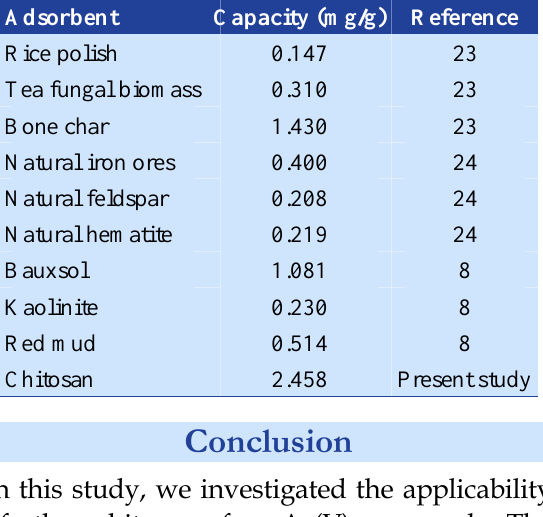
Table 3. Comparison of sorption capacities of chitosan and other adsorbents for the removal of arsenate Adsorbent Capacity